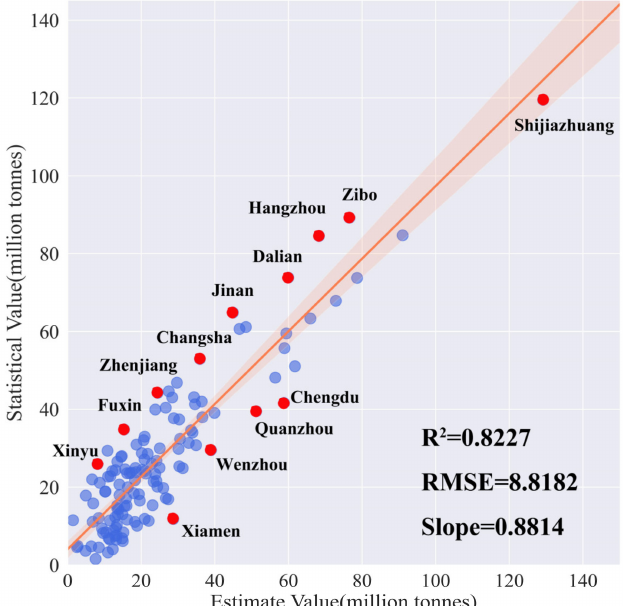
Figure 7. Comparing city-level results of estimation with statistical yearbook